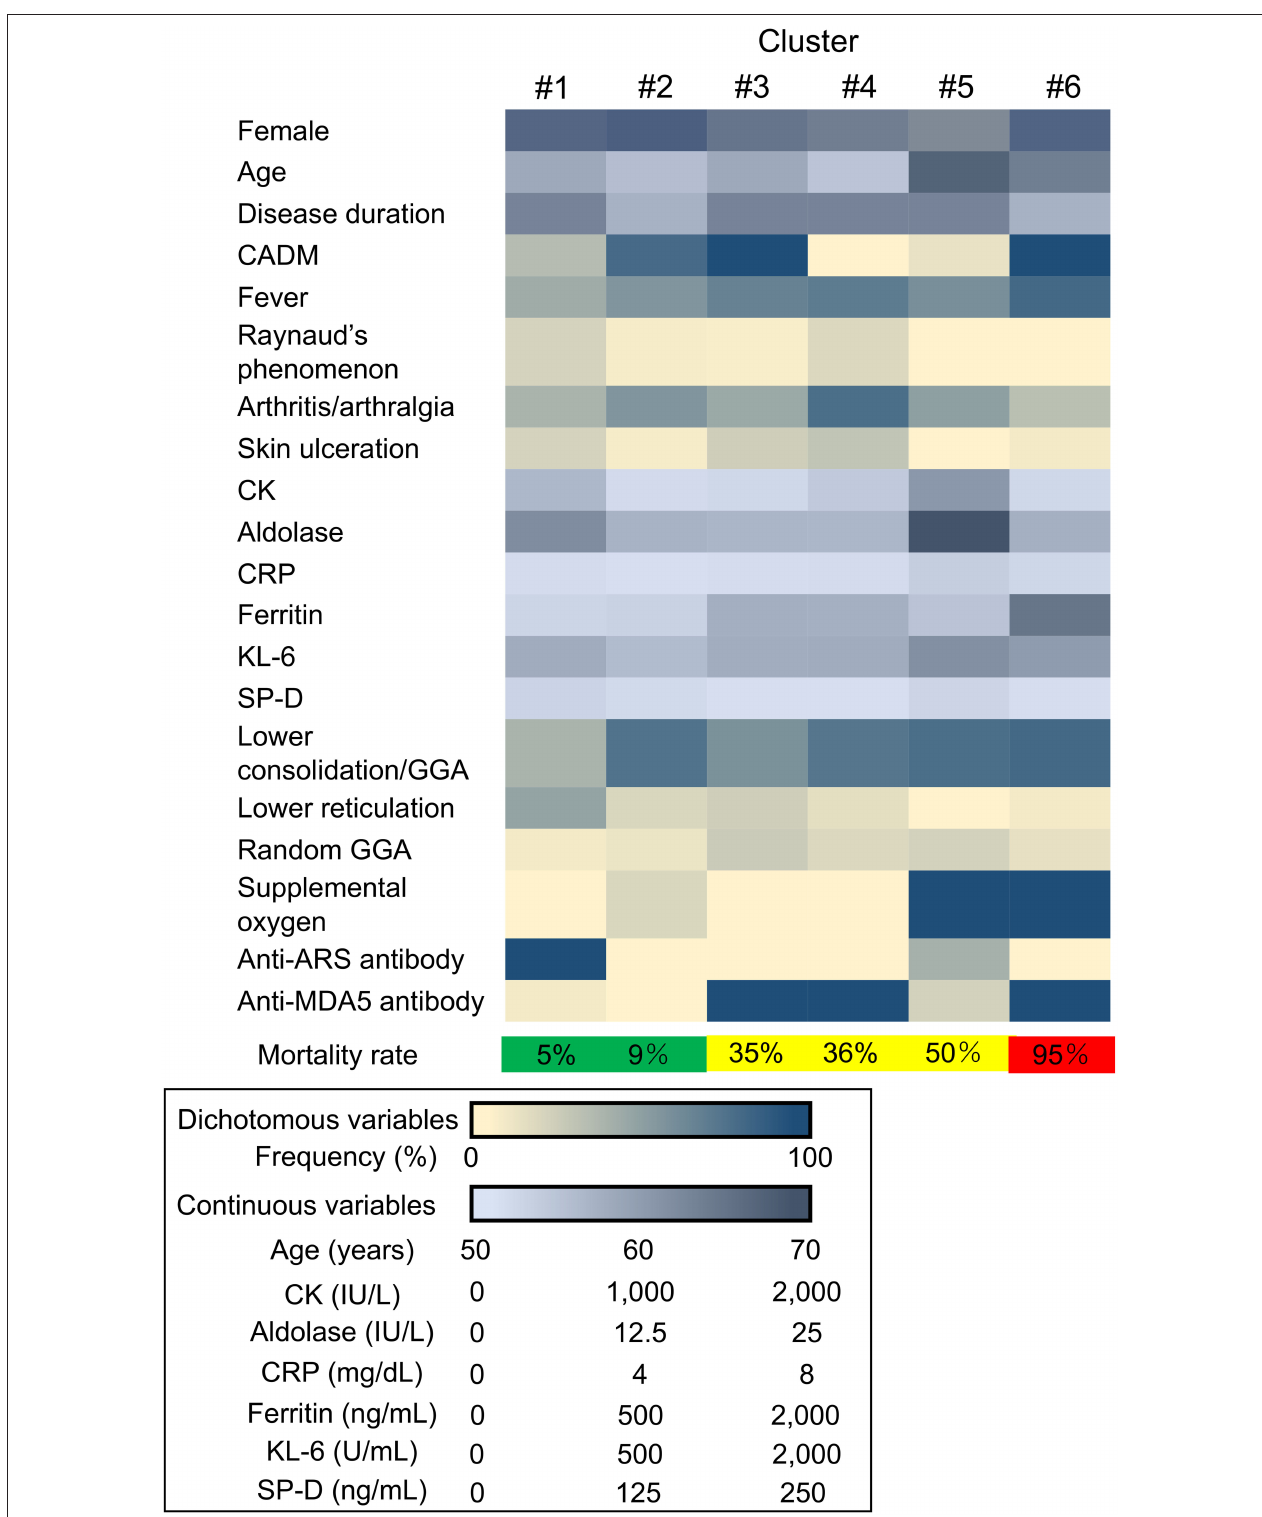
FIGURE 1 | Heatmap showing the clinical characteristics in each cluster. CADM, clinically amyopathic dermatomyositis; CK, creatine kinase; CRP, C-reactive protein; KL-6, Krebs von den Lungen-6; SP-D, surfactant protein-D; GGA, ground-glass attenuation; anti-ARS, anti-aminoacyl transfer RNA synthetase; anti-MDA5, anti-melanoma differentiation-associated gene